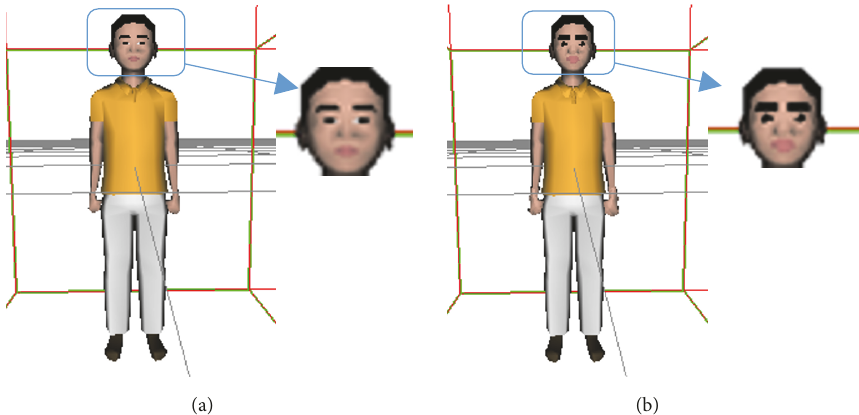
Figure 2: Model points sampling effect. (a) 1246 triangles. (b) 946 triangles, 7773 sampling